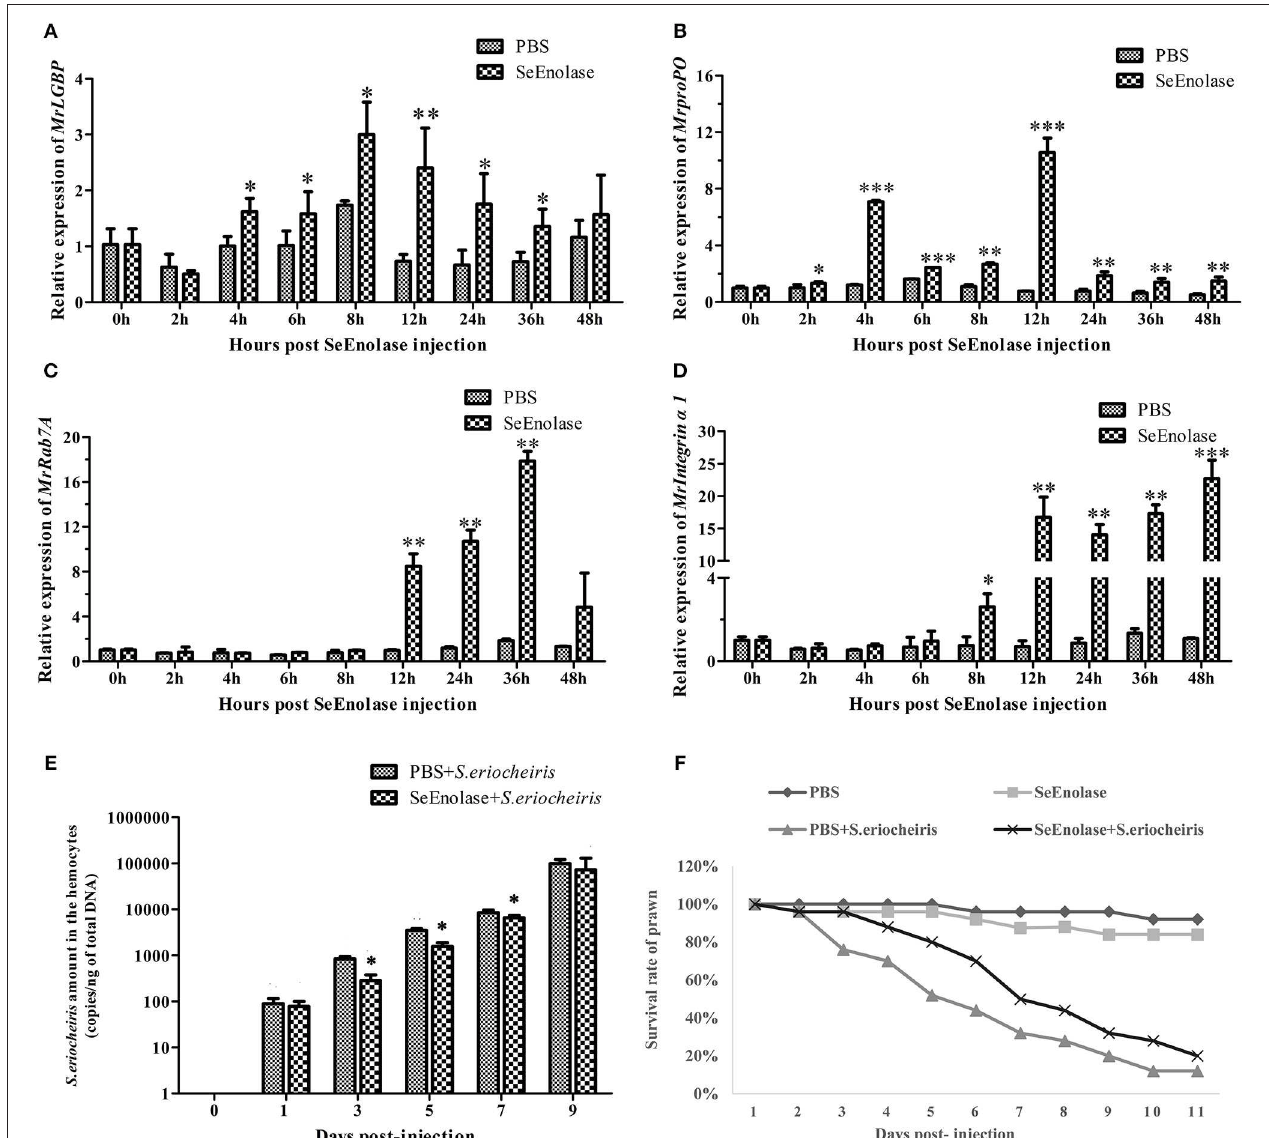
FIGURE 8 | SeEnolase induced immune responses and improved the ability of M. rosenbergii resistance to S. eriocheiris . (A) Transcription levels of MrLGBP in hemocytes after SeEnolase stimulation. Prawns were injected with SeEolase protein as an experimental group and injected with PBS as control group. The hemocytes were sampled from every five individuals at 0, 2, 4, 6, 8, 12, 24, 36, and 48h post-injection. Transcription levels of MrLGBP in hemocytes were analyzed by QRT-PCR. GAPDH was used as a reference gene. Statistical significance was determined by Student’s t -test. Significant differences are indicated: * p < 0.05 and ** p < 0.01. (B) QRT-PCR analysis of MrproPO in prawn hemocytes after SeEnolase stimulation. Statistical significance was determined by Student’s t -test. Significant differences are indicated: * p < 0.05, ** p < 0.01, and *** p < 0.001. (C) QRT-PCR analysis of MrRab7A in prawn hemocytes after SeEnolase stimulation. Statistical significance was determined by Student’s t -test. Significant differences are indicated: ** p < 0.01. (D) QRT-PCR analysis of Mrintegrin α 1 in prawn hemocytes after SeEnolase stimulation. Statistical significance was determined by Student’s t -test. Significant differences are indicated: * p < 0.05, ** p < 0.01, and *** p < 0.001. (E) the quantification of S. eriocheiris copies in hemocytes from the three groups detected by real-time PCR at 1, 3, 5, 7, and 9 days, respectively. Statistical significance was determined by Student’s t -test. Significant differences are indicated: * p < 0.05. (F) The survival rate of SeEnolase stimulation prawn infected with S. eriocheiris . Prawns were injected with SeEnolase protein in SeEnolase + S. eriocheiris group. For PBS + S. eriocheiris group, prawns were injected with PBS. After 12h stimulation, the prawns were received an injection of S. eriocheiris . Two another groups were injected with the SeEnolase or PBS only. The cumulative mortality of prawns was recorded